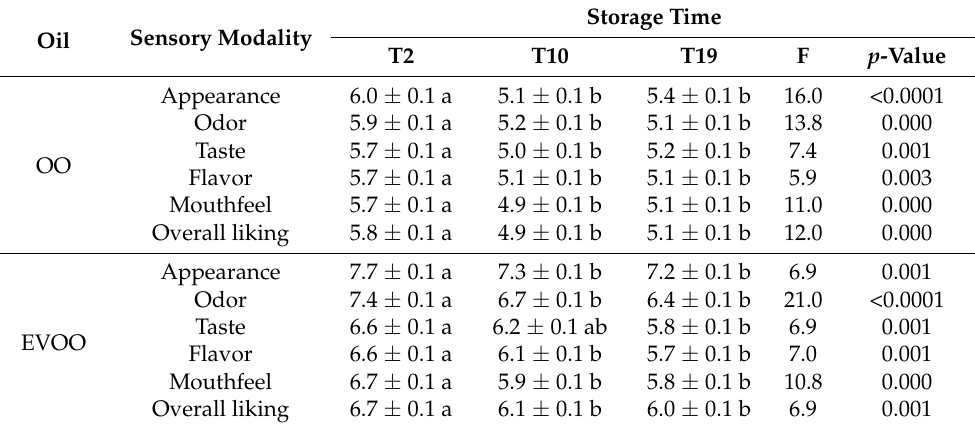
Table 2. Effect of storage time on the acceptability of OO and EVOO (T: storage time; F: Fisher‘s